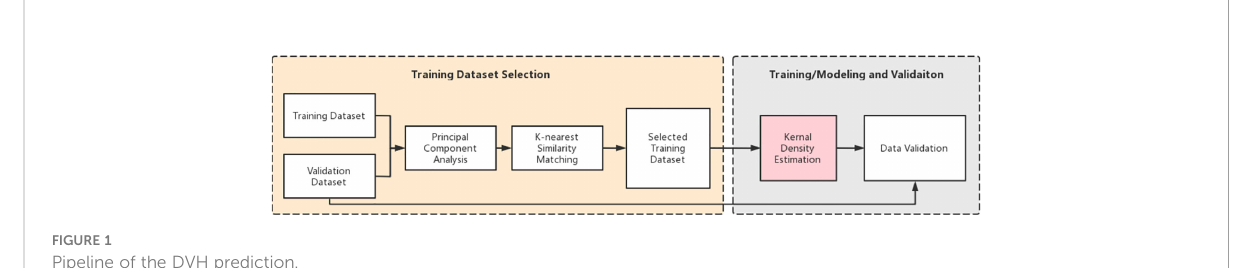
FIGURE 1 Pipeline of the DVH